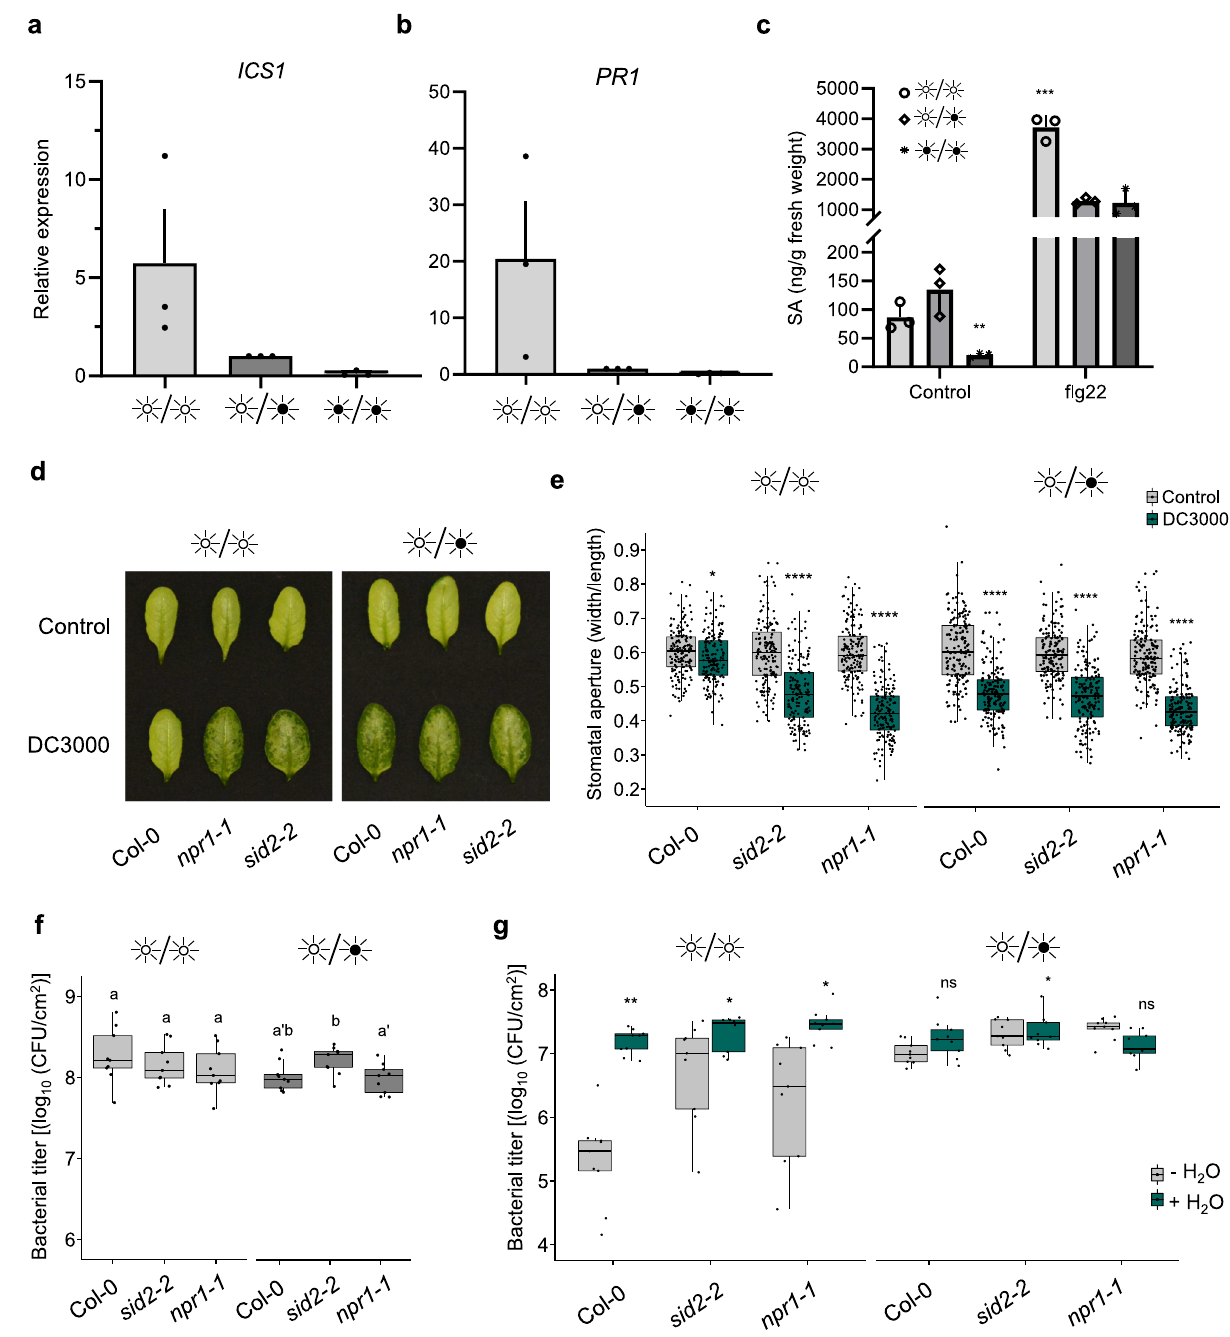
Fig. 3 | Salicylic acid is required for preventing stomatal closure and disease progressionunderconstant light. a , b Expression levels, measuredby qRT-PCR, of SA biosynthesis ( ICS1 ) and signaling ( PR1 ) marker genes in WT Arabidopsis plantstreatedwith1 μ M fl g22afterhavingpreviouslybeenplacedintheidenti fi ed light settings. Samples were harvested at 24 hpi ( n =3 biologically independent replicates). c Quanti fi cation of SA in WT Arabidopsis plants mock inoculated (control)orinoculatedwith1 μ M fl g22underthesameexperimentalsettingsasin a measured by UPLC-MS at 24 hpi ( n =3 biologically independent replicates). d Water-soaking phenotypes in Arabidopsis WT (Col-0), sid2 and npr1 mutant plants syringe-in fi ltrated with Pst DC3000 (1×10 8 CFU/ml) at24 hpiunder LL, LD or DD. e Stomatal aperture measurements from infected leaves displayed in d ( n =159 stomata for all conditions). f Bacterial titers from Arabidopsis WT (Col- 0), sid2 and npr1 mutant plants infected with Pst DC3000 (1×10 8 CFU/ml) at 24